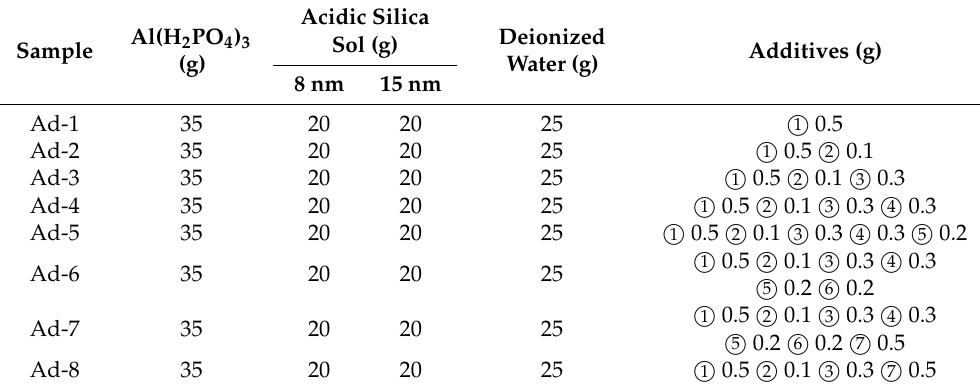
Table 4. Coatings with different additives.